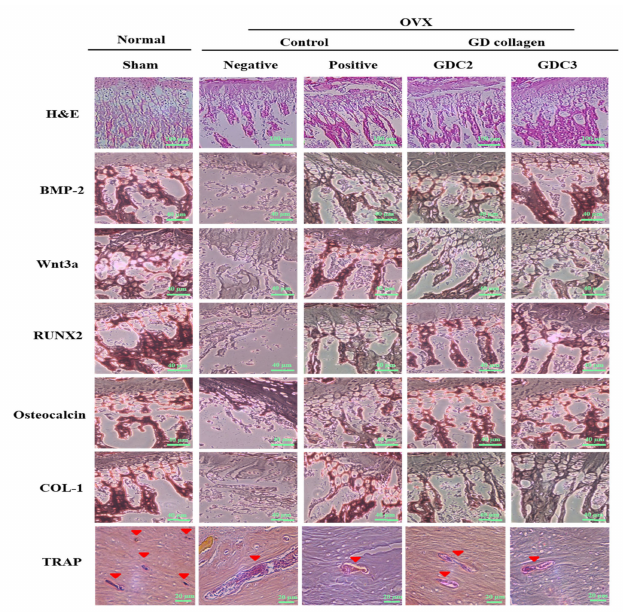
Figure 6. Hematoxylin and eosin (H&E) (scale bar: 100 µ m), and immunohistochemical staining image of bone morphogenetic protein-2 (BMP-2), Wnt3a, runt-related transcription factor 2 (RUNX2), osteocalcin, type 1 collagen (COL-1) (scale bar: 40 µ m), and tartrate-resistant acid phosphatase (TRAP) (scale bar: 20 µ m). GDC2, GD collagen 2 g / Kg and GDC3, GD collagen 3 g /